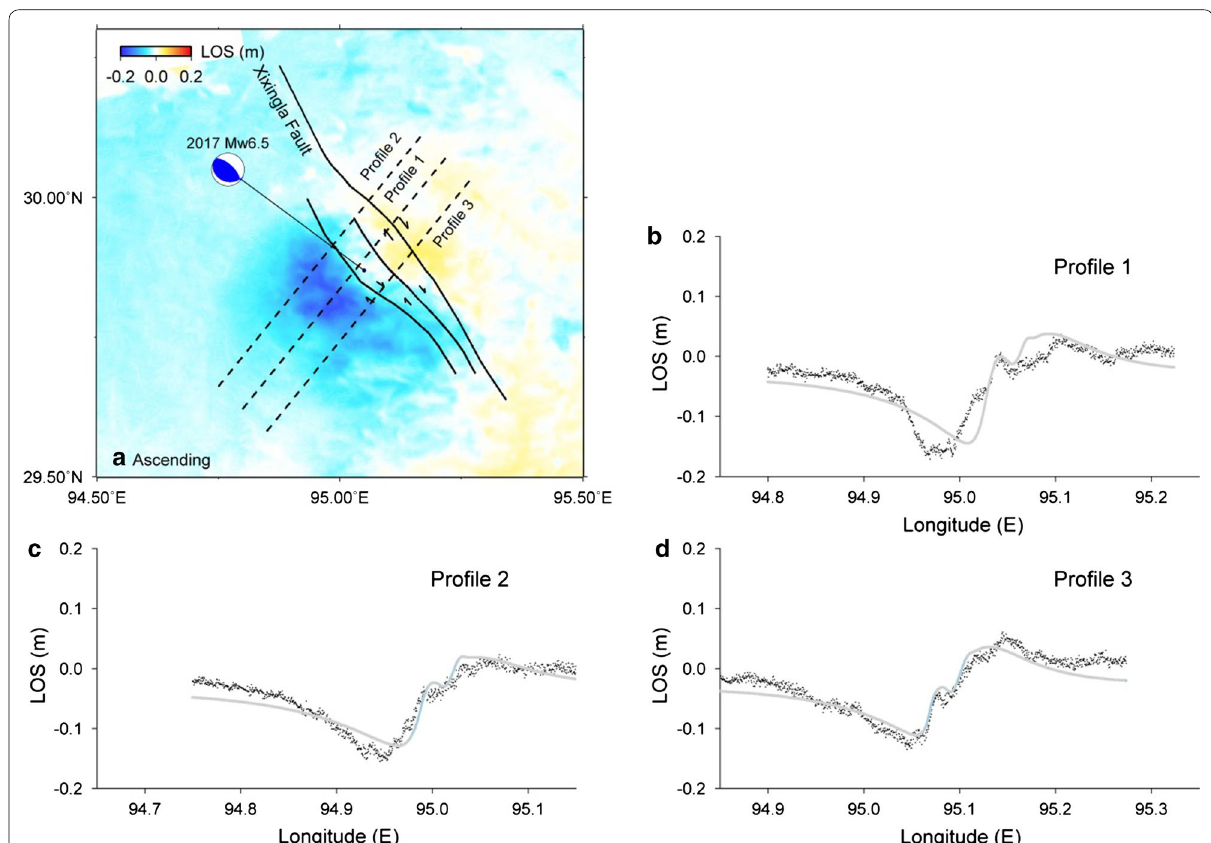
Fig. 2 a Coseismic deformation field of the 2017 Mainling earthquake obtained from the ascending orbit Sentinel-1A images. Black lines are the preexisting faults (Yin et al. 2018a). b – d Coseismic displacements observed by ascending orbit are plotted as black dots along each profile, while the model-predicted displacements are plotted as gray